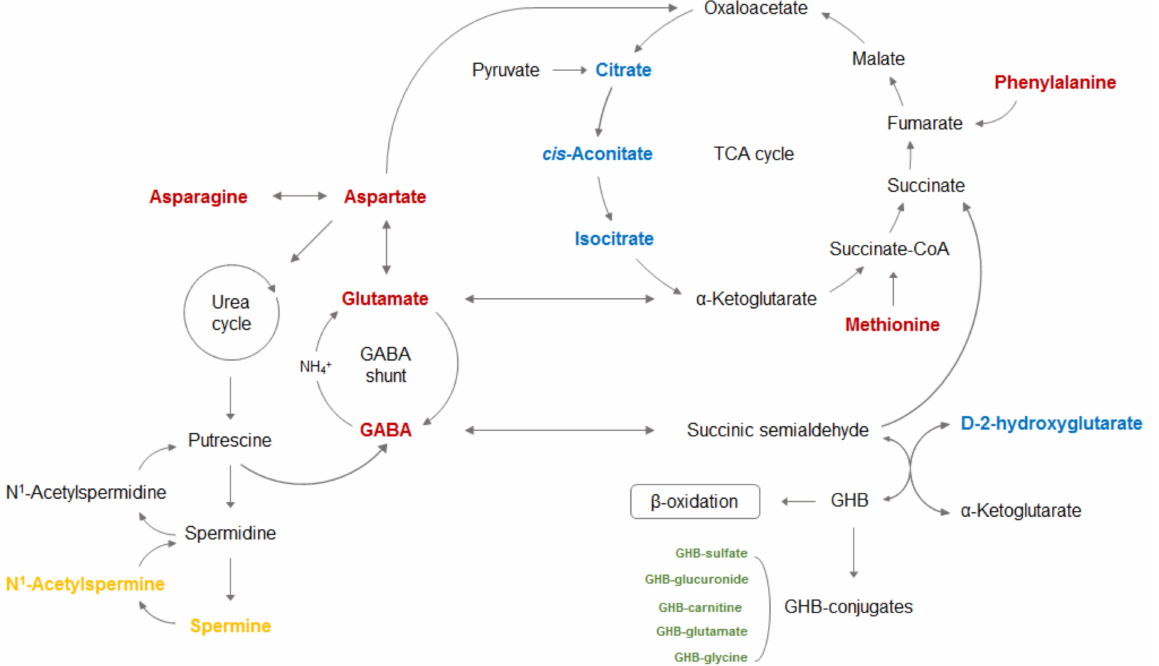
Figure 2. Altered metabolic pathway associated with GHB exposure based on findings from previous studies using rats and humans. Proposed biomarkers are displayed in the following colors (blue color, organic acid; red color, amino acid; yellow color, polyamine; green color,